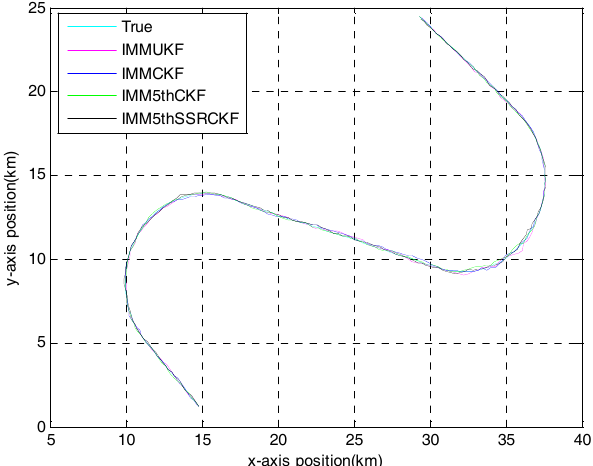
Figure 2. Trajectory of the maneuvering target. IMMUKF: interacting multiple model unscented Kalman filter; IMMCKF: interacting multiple model cubature Kalman filter; IMM5thCKF: interacting multiple model fifth-degree cubature Kalman filter; IMM5thSSRCKF: interacting multiple .model fifth-degree spherical simplex-radial cubature Kalman filter